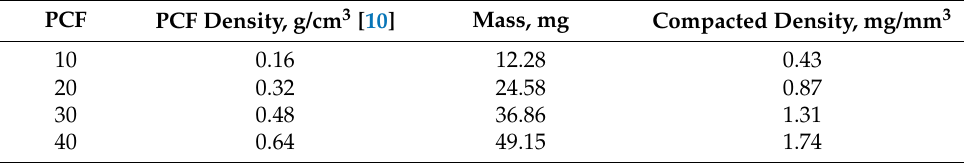
Table 3. Calculated values for chosen PCF densities after a pilot